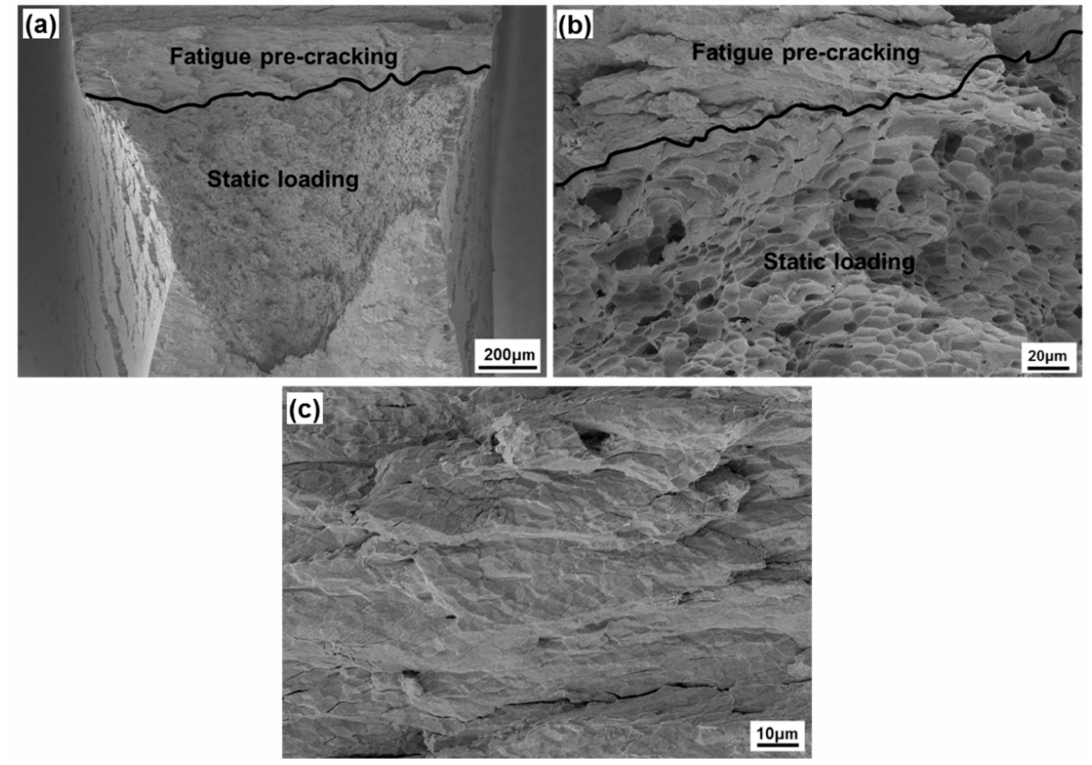
Figure 7. Fracture surface of J-R tested DCT specimen (pre-cracked at 600 ◦ C and tested at 700 ◦ C in Ar gas environment): ( a ) low magnification, ( b ) details of transition area from fatigue pre-crack to